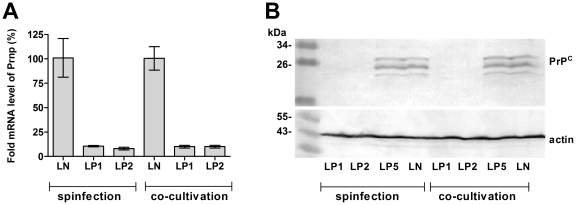
Downregulation of PrPC expression by RNAi in MEL cells after selection with puromycin.(A) Both methods of retroviral vector delivery led to ∼90% silencing of Prnp mRNA in both lines expressing anti-Prnp shRNAmir (LP1 and LP2) when compared with the MEL line expressing nonsilencing shRNAmir (LN), as depicted by qRT-PCR. (B) Confirmation of PrPC downregulation in LP1- and LP2-transduced cells at the protein level by western blot. PrPC was detected by mAb AH6. No silencing was observed in LP5 cell line. Actin was used as a loading control.